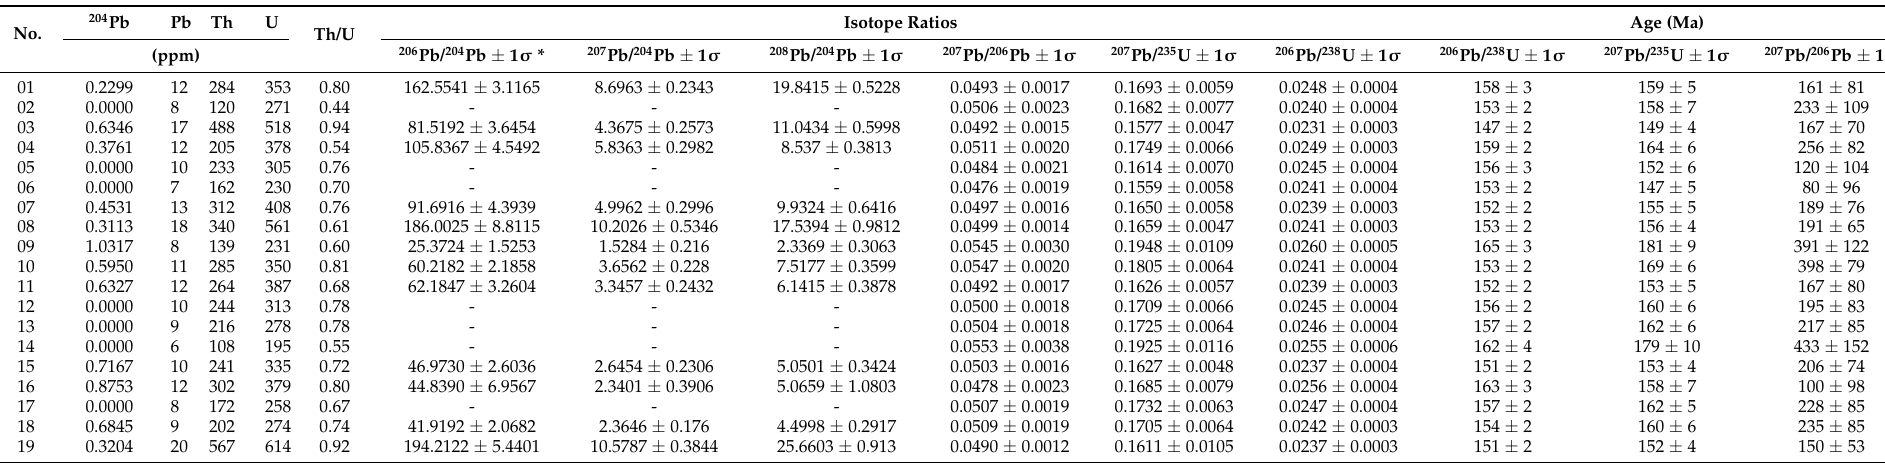
Table 5. Zircon U-Pb isotopic compositions and geochronological results of the No. 3 granodiorite in the Shuikoushan